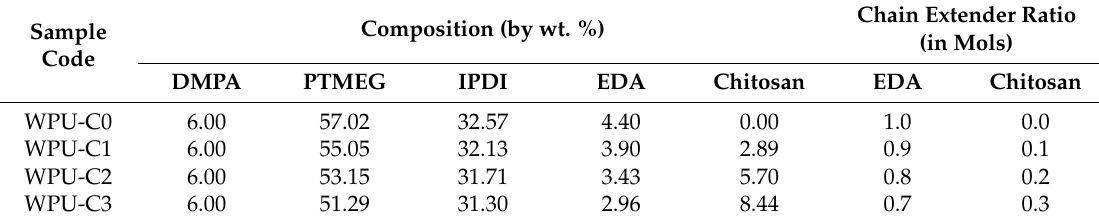
Table 1. Sample codes and recipes for different